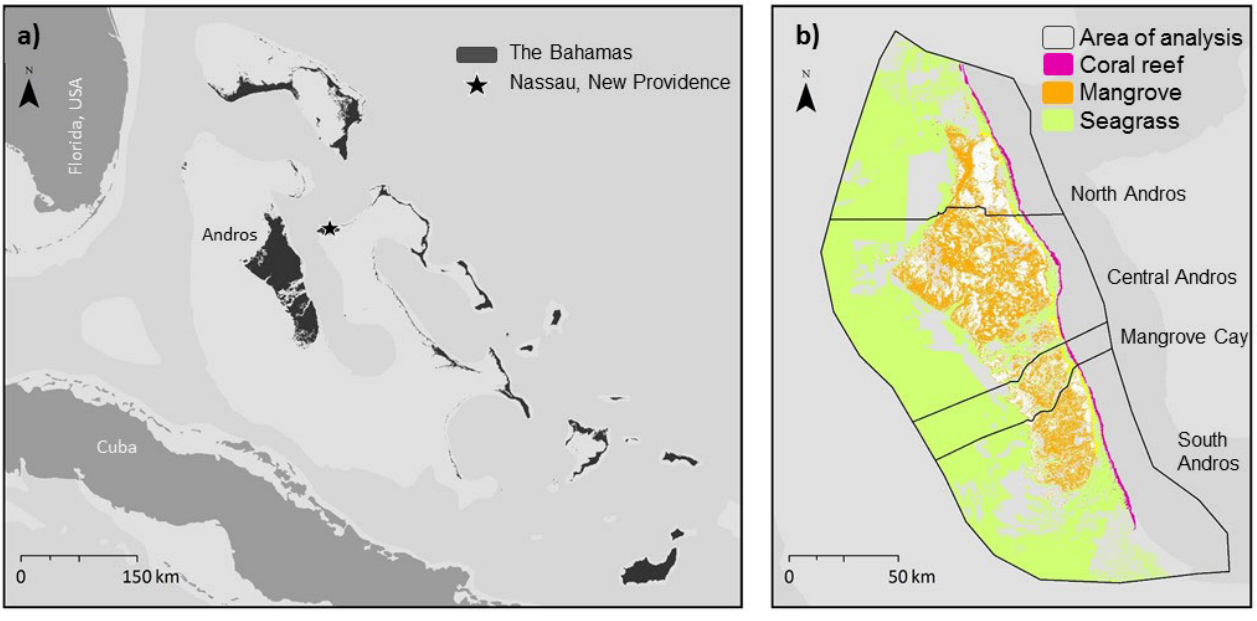
Fig. 2 . Andros is the largest island in The Bahamas (a) and comprises four districts: North Andros, Central Andros, Mangrove Cay, and South Andros (b). Mangroves cover much of the island, a barrier reef shadows its eastern shoreline, and seagrass extends off the north and western shores